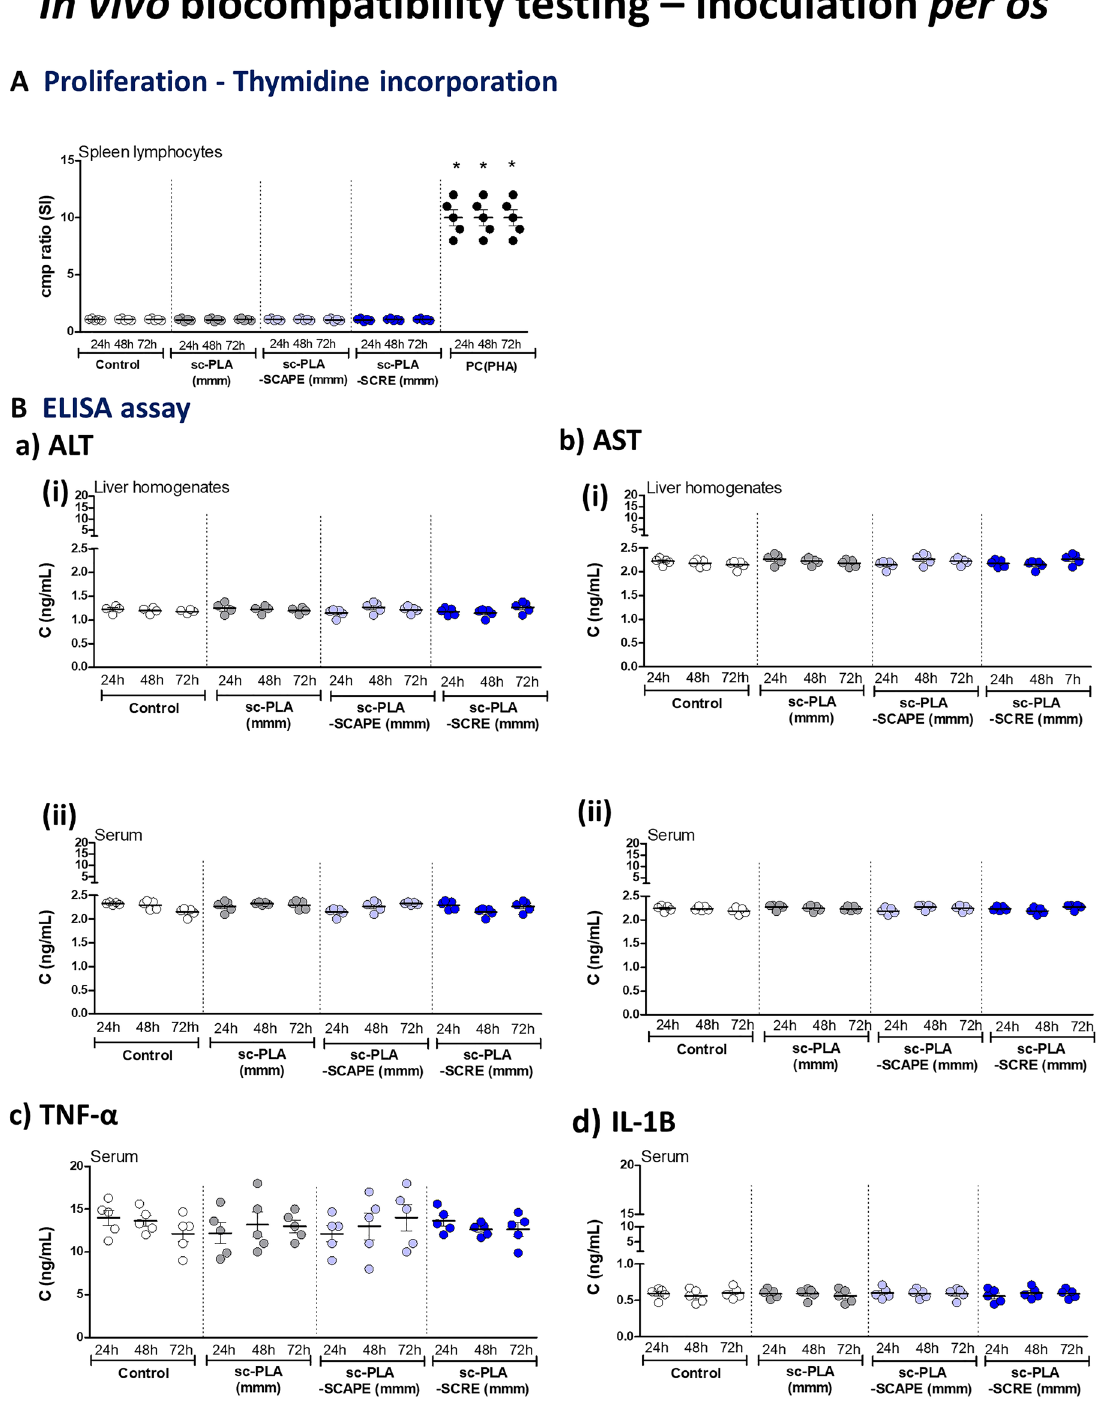
Figure 6. In vivo biosafety of tested stereocomplexed microparticles sc-PLA with medium molecular mass— sc-PLA (mmm) alone or such particles loaded with S. cadmica aerial part extract—sc-PLA-SCAPE (mmm) or S. cadmica root extract—sc-PLA-SCRE (mmm) after oral administration to guinea pigs. At 24, 48 and 72 h after inoculation of animals with tested formulations or physiological saline (control animals) the animals were terminated and spleen, liver and blood samples were collected for further evaluation. (A) Splenic lymphocytes were tested for proliferation towards mitogen—phytohemagglutinin (PHA) as positive control (PC) by ( 3 H)-thymidine incorporation into cellular DNA. Stimulation index (SI) was calculated by dividing the radioactivity counts (cpm/min) of cells stimulated with S. cadmica extracts or microparticles by radioactivity of cells in culture medium alone. ( B ) The level of alanine aminotransferase—ALT ( a ) and aspartate aminotransferase—AST ( b ) in liver homogenates (i) or serum samples (ii); the level of tumor necrosis factor alfa (TNF-α) ( c ) and interleukin (IL)-1B ( d ) in serum samples, detected by the enzyme linked immunosorbent assay- ELISA assay. Five animals per group were examined. The results are presented as median values ±